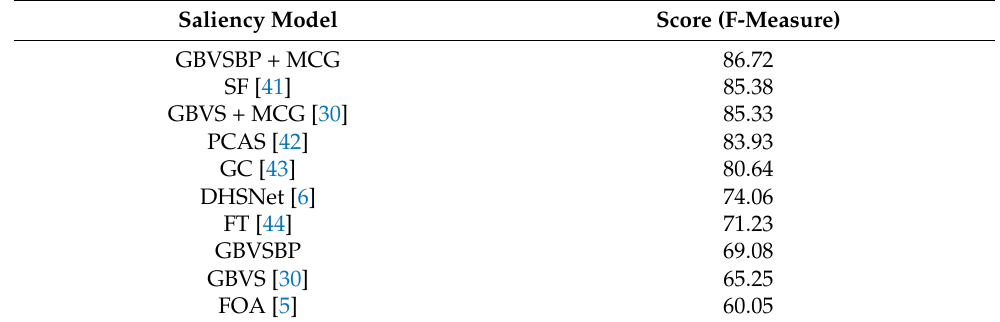
Table 19. Comparison using the benchmark with other algorithms in the FT database [30]. This ranking of solutions applies a set of images separated from the rest of the photos as a challenging test. The evolved solution improves the original proposal and defeats DHSNet by a large